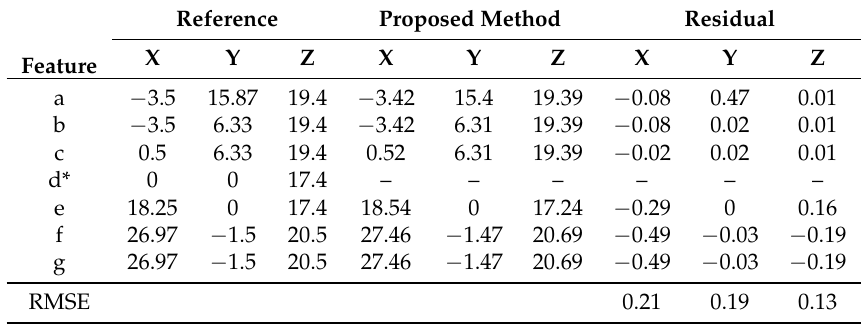
Table 4. The error analysis of 3D point measurement in the video frame cut test case (unit: